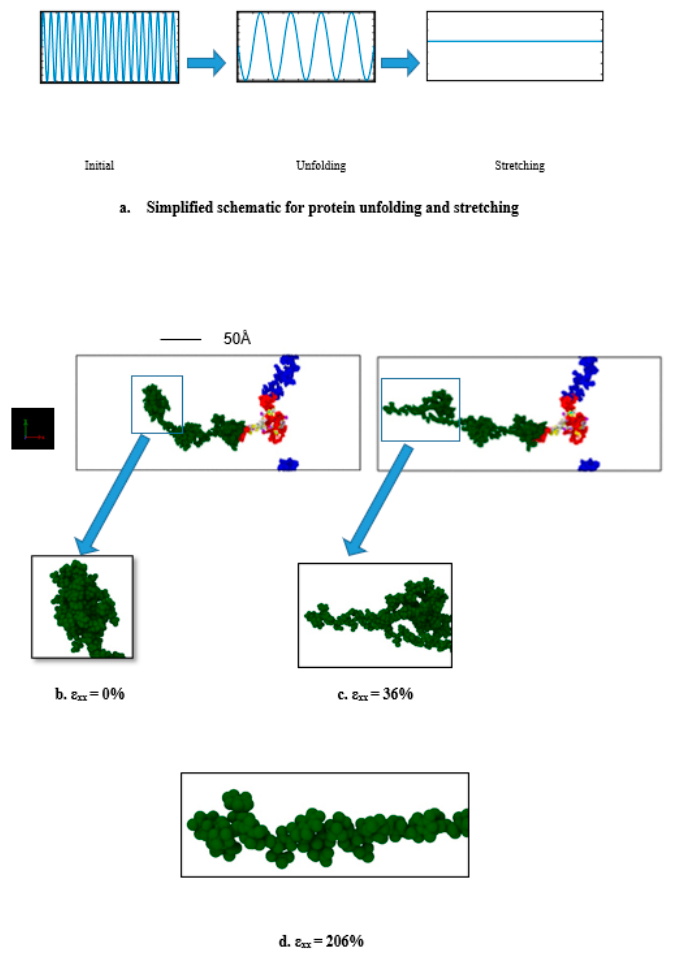
Figure 1. Stress vs. strain plot of single tau projection domain. Up to ~200% strain, the protein keeps unfolding, and after that a sharp rise in the slope is observed, suggesting the pure stretching of covalent bonds. Unfolding and stretching zones are shown in rectangular boxes.